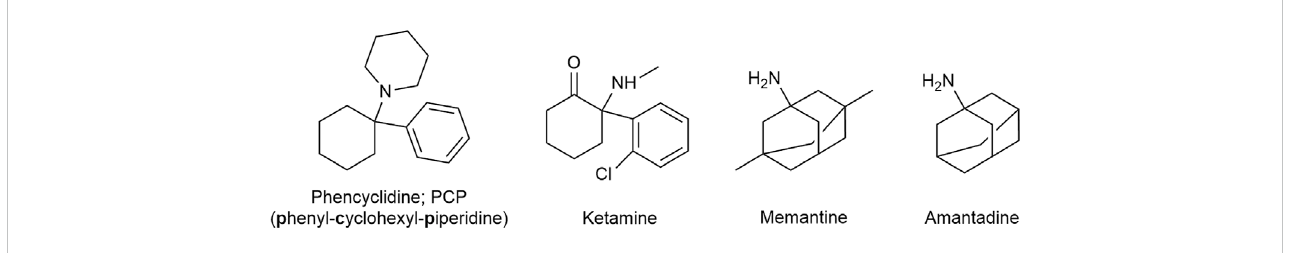
FIGURE 14 Ketamine is related to Phencyclidine. Memantine is an amantadine